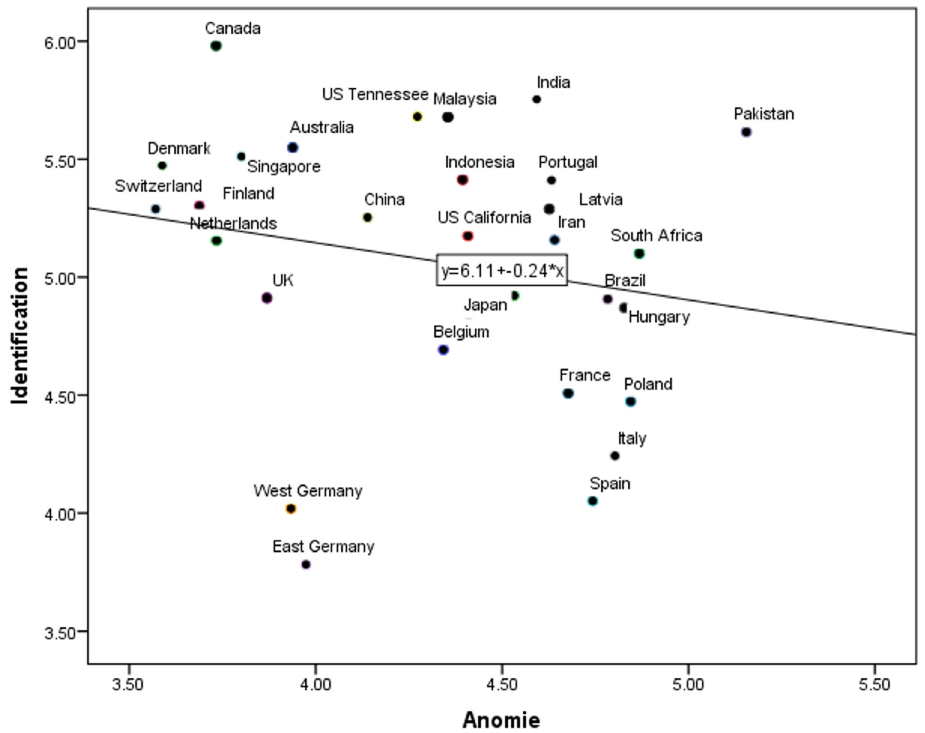
Fig 2. Relation between PAS and identification across